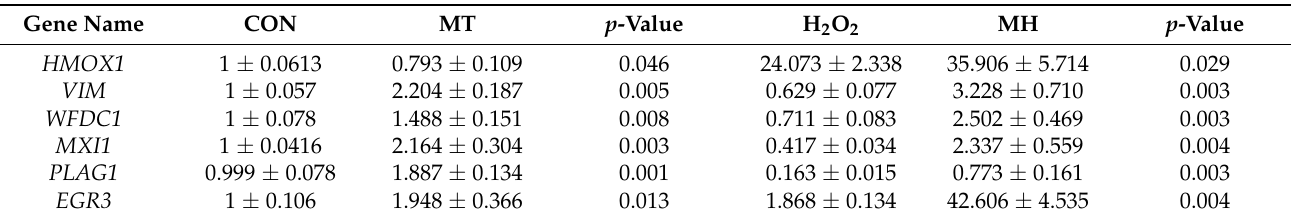
Table 1. RT-qPCR measurement of differential gene expression.